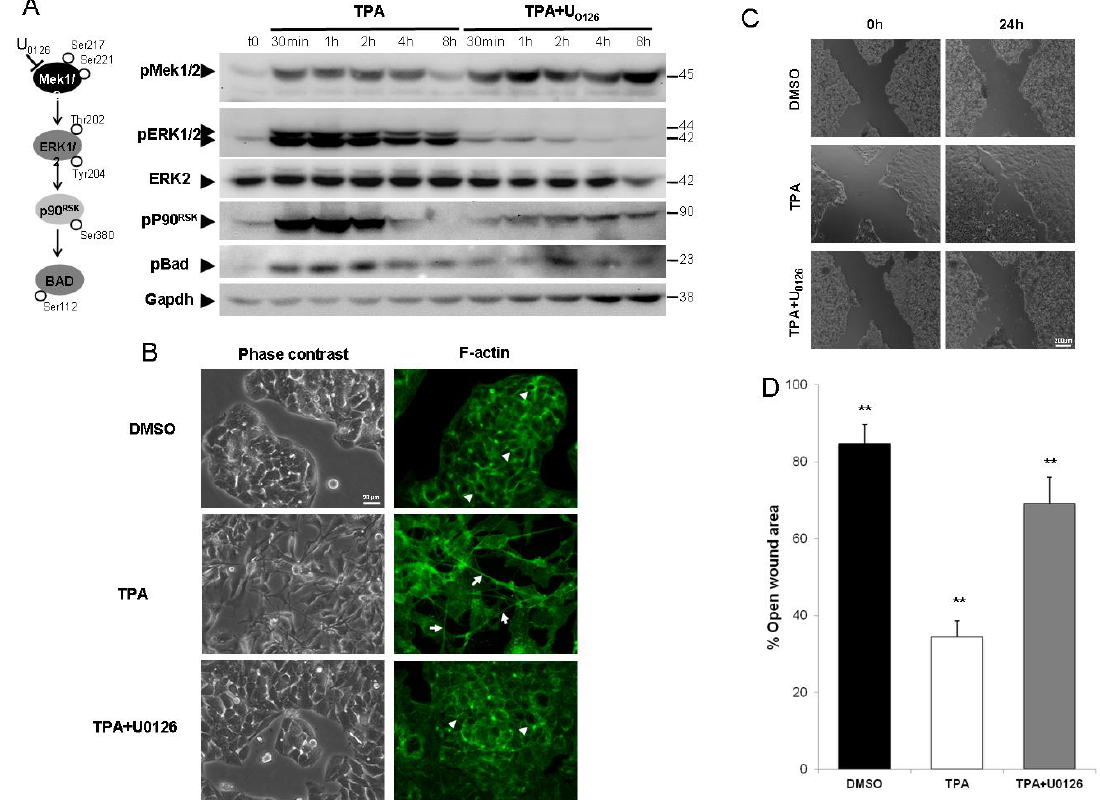
Figure 1. The inhibition of ERK1/2 activation by U0126 prevents HepG2 cell migration. ( A ) HepG2 cells were exposed to 100 nM tumor promoter 12- O -tet-radecanoylphorbol-13- acetate (TPA) for 30 min to 4 h, with or without U0126. Cells were lysed and subjected to western blotting, as described in Section 2. The ERK1/2 signaling pathway was studied by analyzing the phosphorylation of MEK1/2, ERK1/2, P90rsk and Bad, together with ERK2 levels. As a control, the same membranes were also probed with an antibody directed against Gapdh; ( B ) 24 h after TPA treatment, cell morphology was examined under a light microscope. F-actin was visualized by AlexaFluor 488-conjugated phalloidin staining (green) and fluorescence microscopy; ( C , D ) The subconfluent HepG2 cells were wounded 48 h after plating and exposed to TPA or TPA + U0126. Images were obtained 24 h after treatment ( C ). Percentages of open wound area at 24 h, in each set of conditions, as in ( C ), were plotted, with wound width was normalized with respect to the initial value at 0 h ( D ). Errors bars indicate the mean ± SEM of triplicate determinations in three independent experiments. ** p <